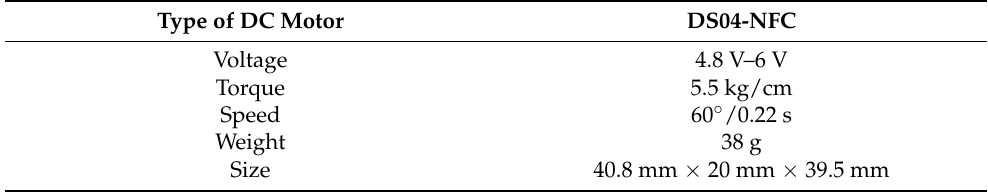
Table 1. Parameters of the DS04-NFC DC motor.